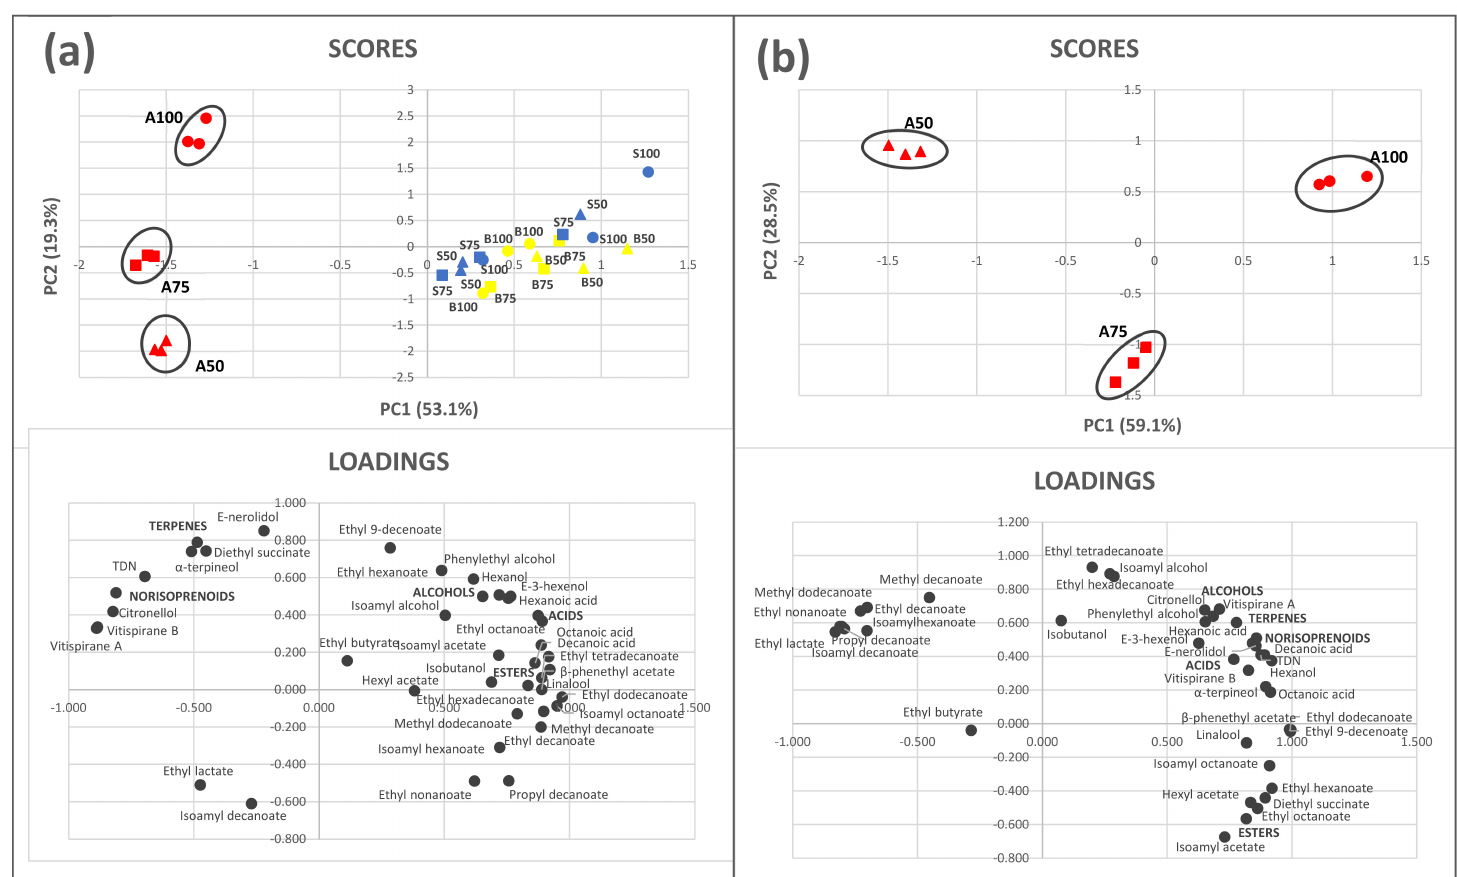
Figure 5. Data scores and loading biplot on the plane of the first two principal components (PC1 against PC2) of ( a ) Sparkling wines STAGE 1 (B50, B75, B100), STAGE 2 (S50, S75, S100), STAGE 3 (A50, A75, A100) ( b ) Sparkling wines from STAGE 3 (A50, A75, A100). B50, B75, and B100 (wines before second fermentation with the first addition of bentonite); S50, S75, and S100 (sparkling wines after second fermentation with the second addition of bentonite); A50, A75, and A100 (sparkling wines after 9 months of aging on